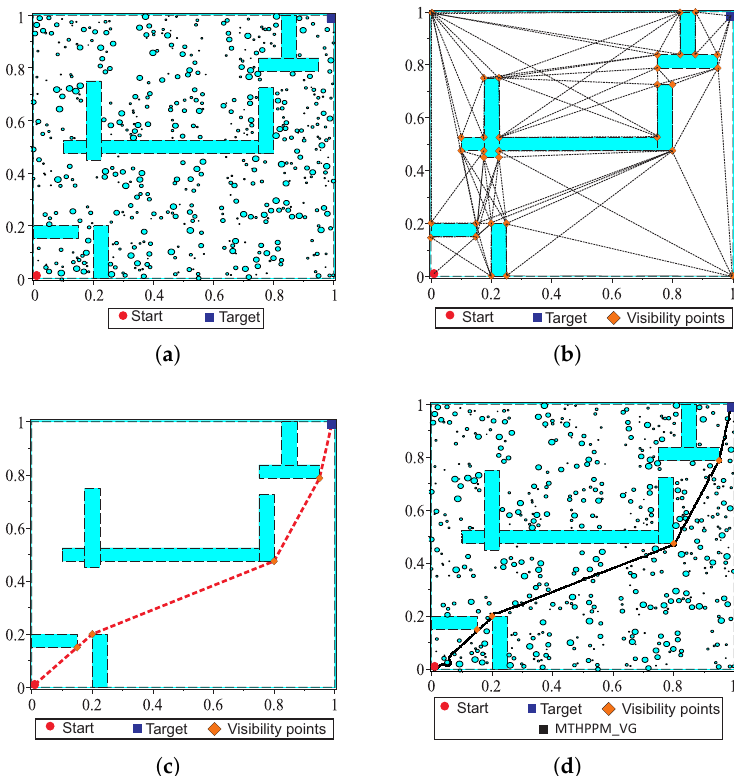
Figure 15. Visibility approach applied to Homotopic Path Planning Method. ( a ) Environment map with walls. ( b ) Visibility points and pre-processed path. ( c ) Visibility graph path without circular obstacles. ( d ) Solution path obtained by MTHPPM using the visibility